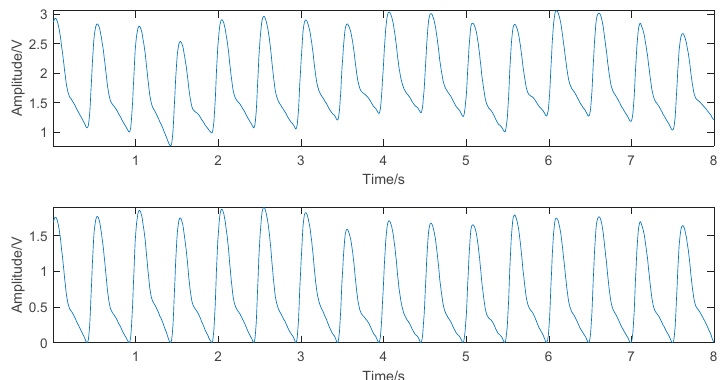
Figure 5. Comparison of the photoplethysmogram (PPG) signal before ( top ) and after ( bottom ) denoising.